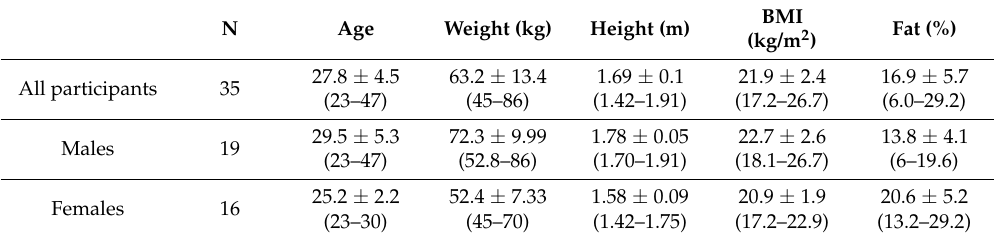
Table 1. Sedentary office workers’ physical